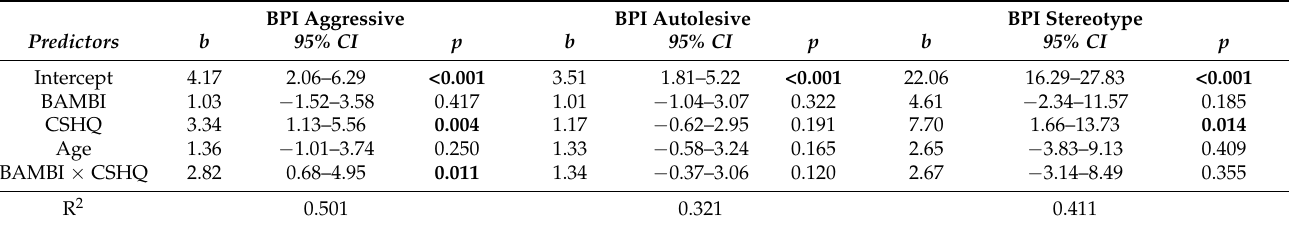
Table 4. Linear regression models with BPI scores as dependent variables.